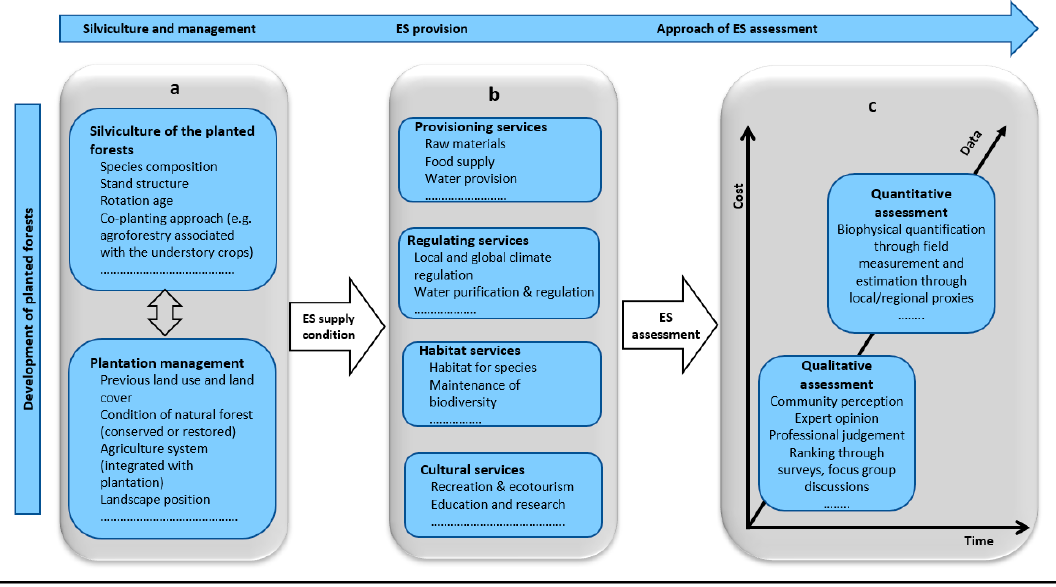
Figure 2. A framework for assessing ecosystem services (ES) from planted forests in Vietnam. The framework consists of three main components: ( a ) silviculture and management of planted forests that influences the quality of forests and supply of ES; ( b ) potential provisioning of ES based on the classification system proposed by The Economics of Ecosystems and Biodiversity (TEEB), and ( c ) the main approach of assessing ES which is associated with cost, time and data. The selection of approach/method and the assessment of ES depends on the available cost, time and data requirement for the assessment (Adapted from [16,34–36]). Valuation of ES depends on the scale of benefit, which varies from local to wider scales (Adapted from [37]).